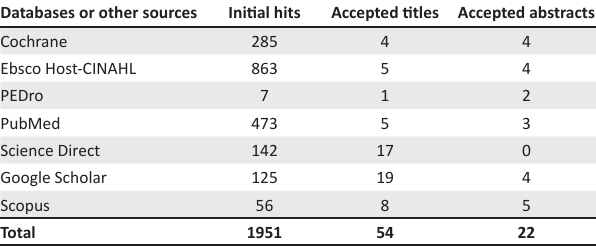
TABLE 1: Article identification search strategy. Databases or other